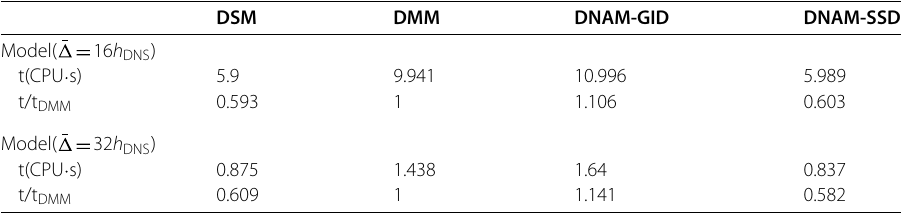
Table 5 The computational cost of SGS stress modeling ij for LES computations with the filter scales